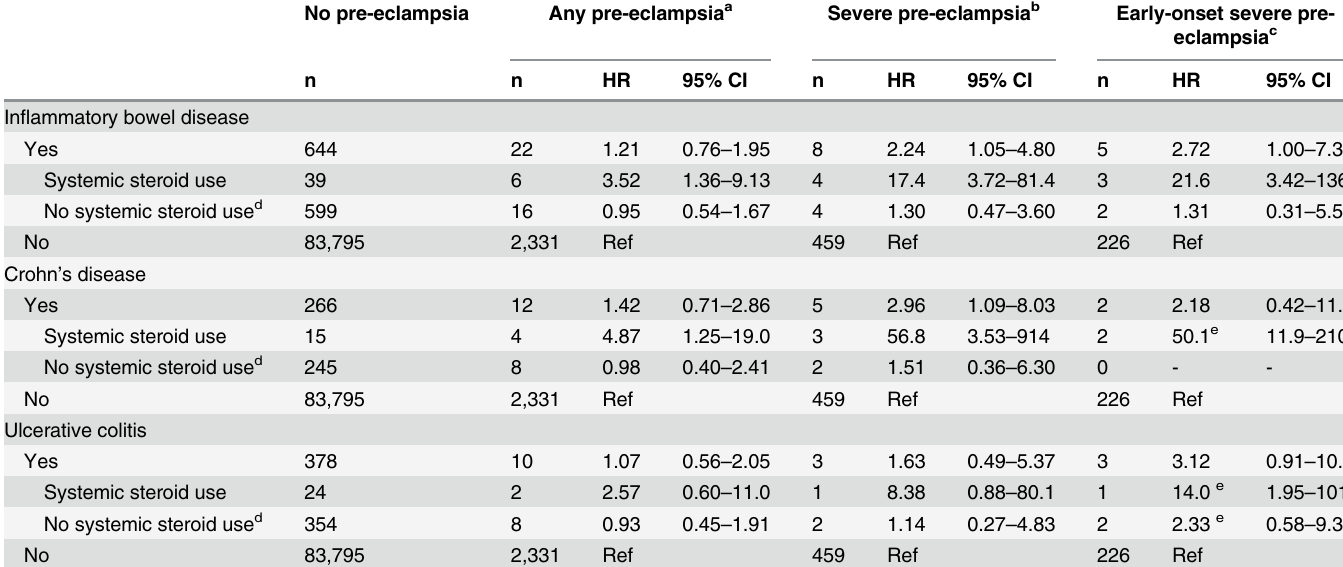
Table 1. Associations between inflammatory bowel disease, medication use and rates of pre-eclampsia in the Danish National Birth Cohort, 1996 – 2003 No